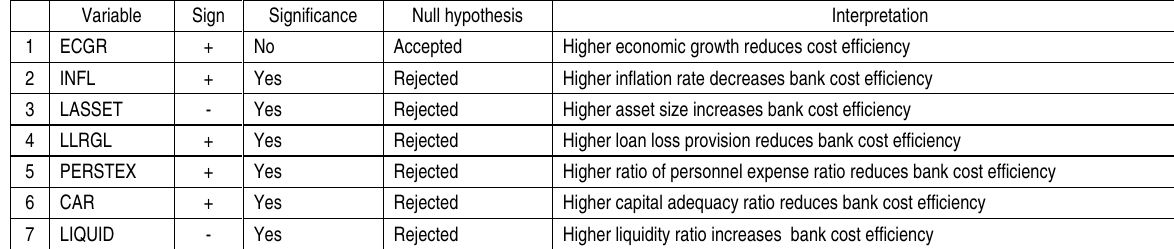
Table 8. Summary of the